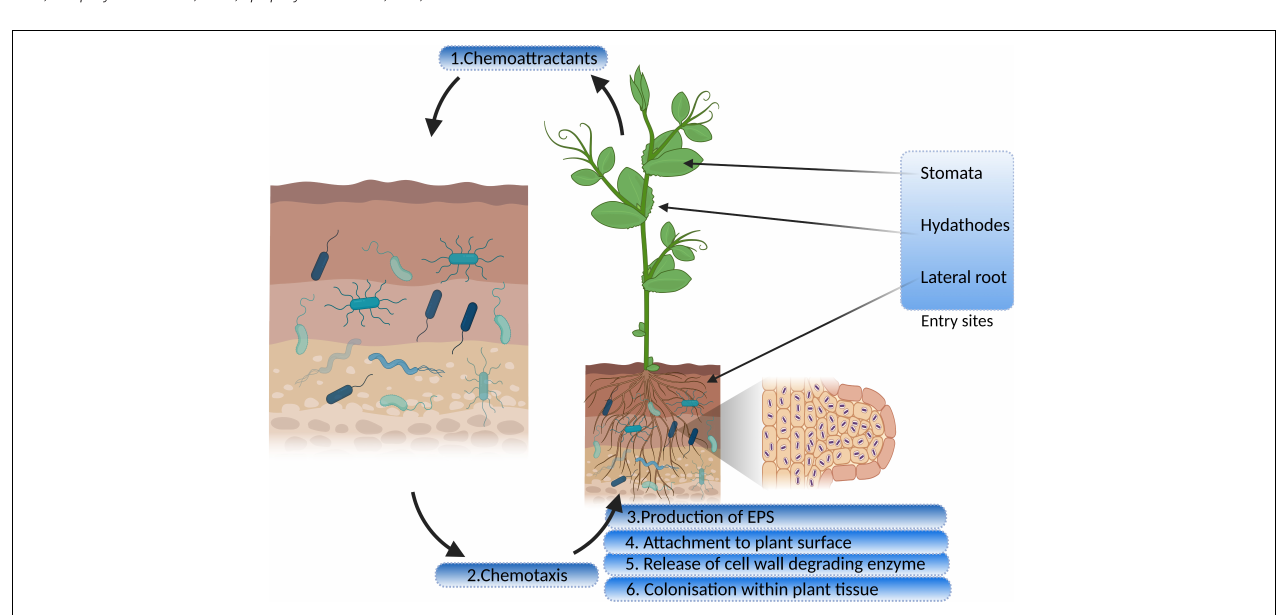
FIGURE 1 | Interaction and colonization of plant growth-promoting endophytic bacteria in the host plant (EPS, exopolysaccharides).